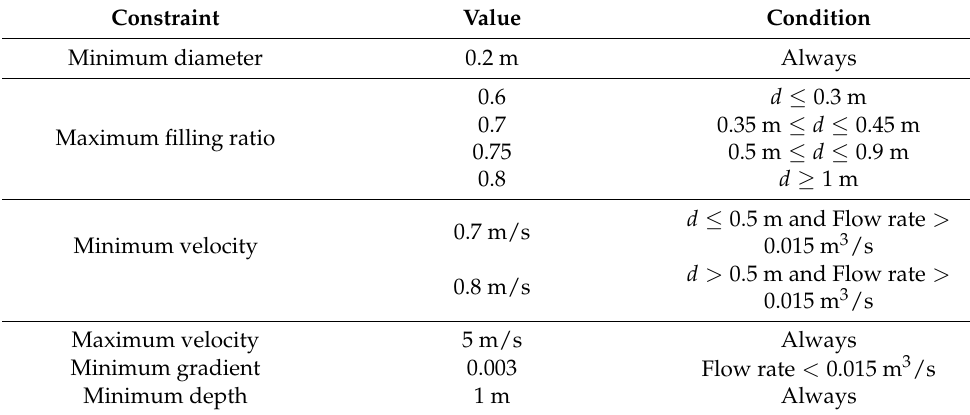
Table 1. Hydraulic constraints.